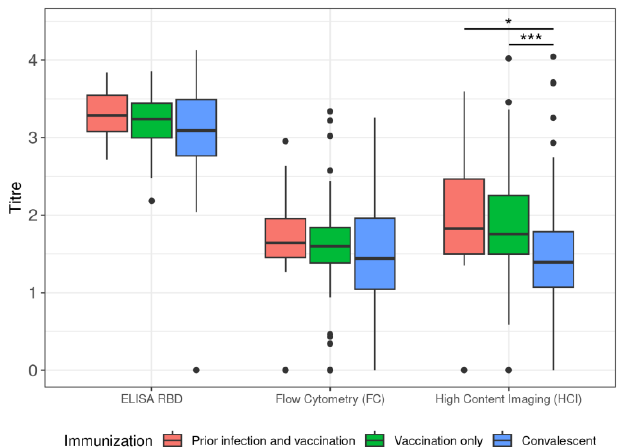
Figure 12. A comparison of titre distribution between the used methods and di ff erent subgroups of our participants. * p < 0.05; *** p < our participants.